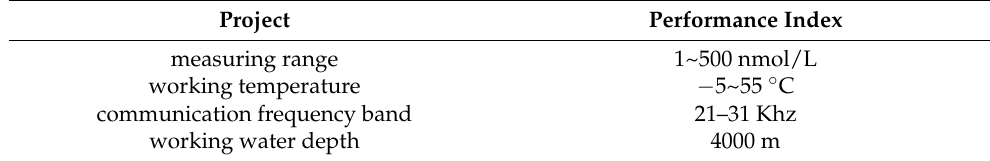
Figure 3. Schematic diagram of the system. Table 1. Main technical indicators of the